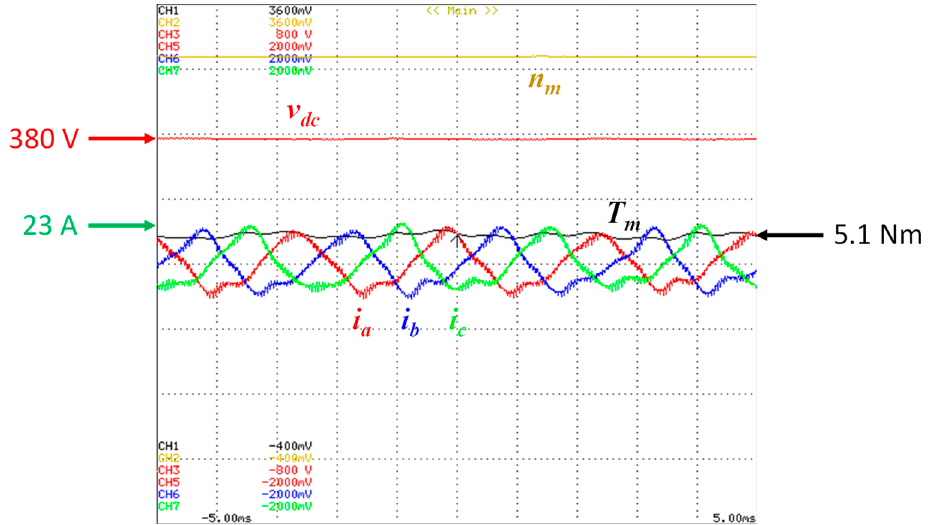
Figure 16. Experimental results of the traction system operating at a constant speed (6000 rpm) without a load: the torque ( T m ) and speed ( n m ) of the SRPM machine; dc-link voltage ( v dc ); stator windings’ currents ( i a , i b , i c ).